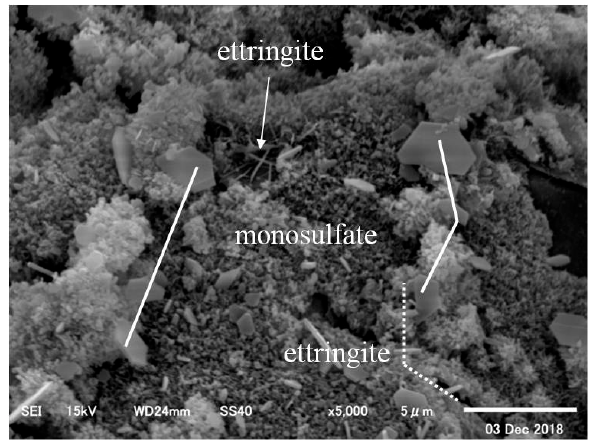
Figure 12. CN0 (×5000)–2. Figure 12. CN0 ( × 5000)–2.